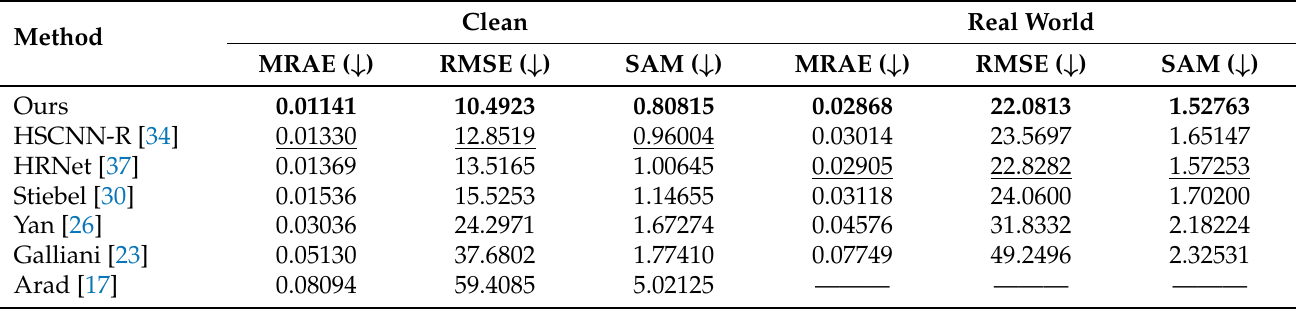
Figure 7. Visual comparison of the five selected bands on “BGU_HS_00265” image from the final testing set of NTIRE2018 “Clean” track. The best view on the screen. Table 4. The quantitative results of final test set of NTIRE2018 “Clean” and “Real World” tracks. The best and second best results are bold and